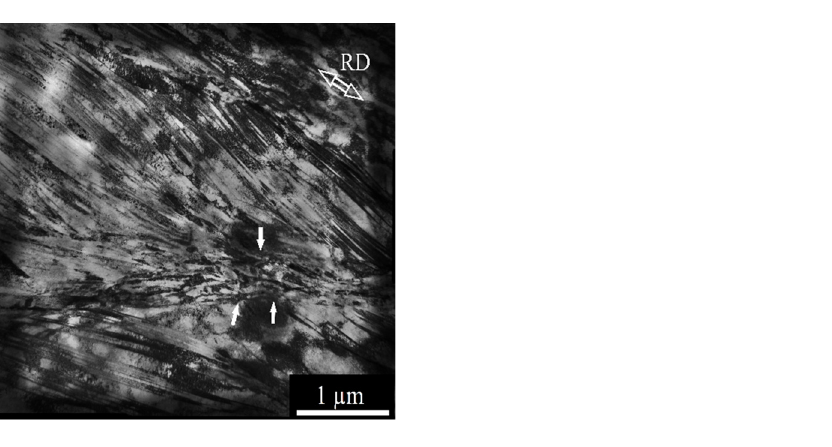
Figure 3. TEM image of the microstructure of the N2 alloy after cold rolling to 80% thickness reduction. The RD arrow indicates the rolling direction.